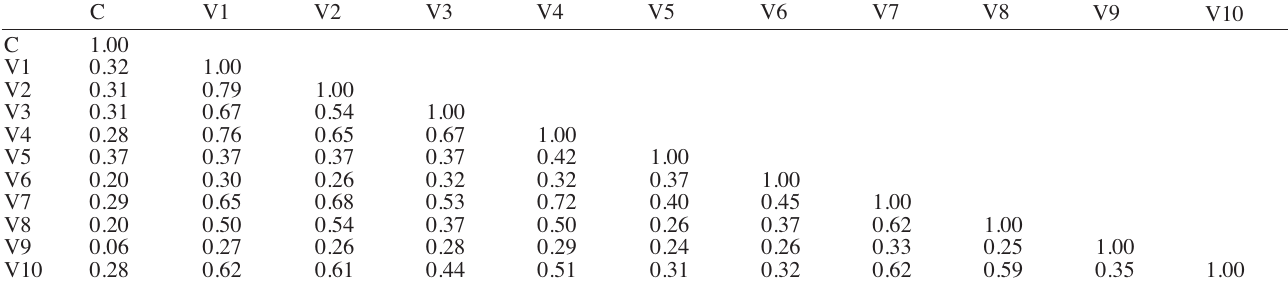
Table 5 - Jaccard’s similarity matrix in control (C) and mutated (V) plants based on RAPD